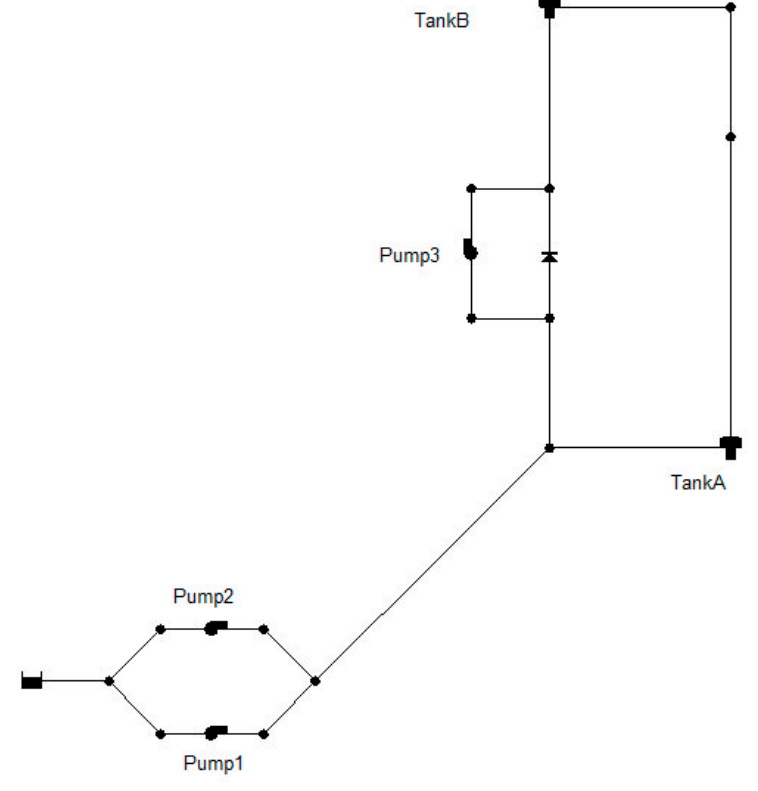
Figure 2. Case 1—Van Zyl et al. (2004), Water Distribution Network (WDN).